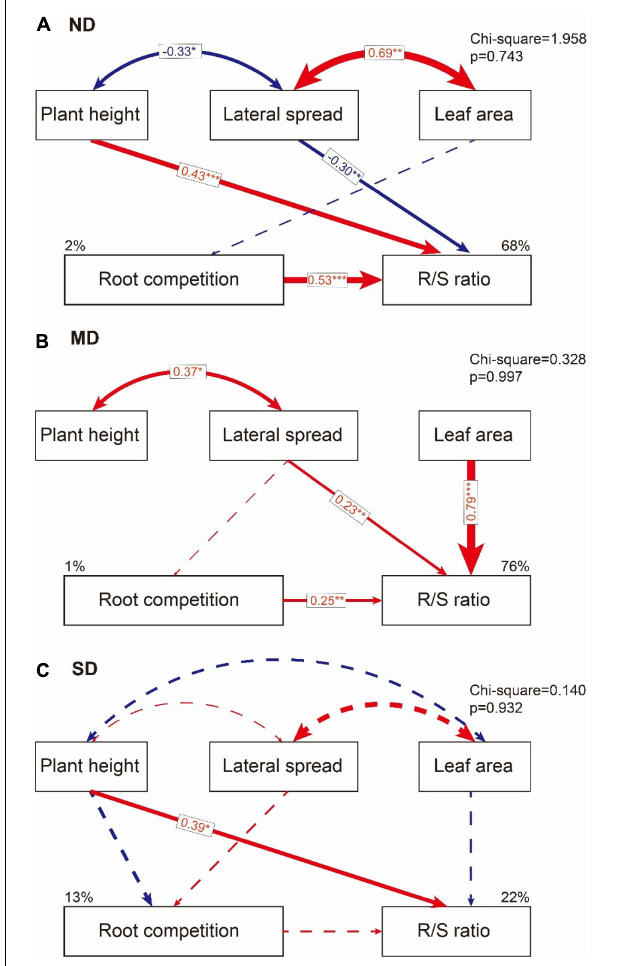
FIGURE 6 | The direct and indirect effects of plant height, lateral spread, and leaf area on root competition and R/S ratio in (A) no obvious degradation (ND) plots, (B) moderate degradation (MD) plots, and (C) severe degradation (SD) plots. The blue line means negative effects and the red line means positive effects. The solid line means significant path (* p < 0.1; ** p < 0.05; *** p < 0.01). The dashed line means a non-significant path that helped to improve model